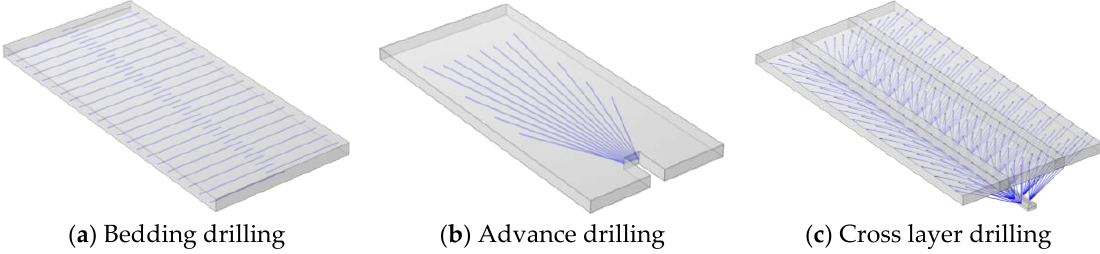
Figure 24. Pressure relief and permeability enhancement mode of high-gas coal seam.